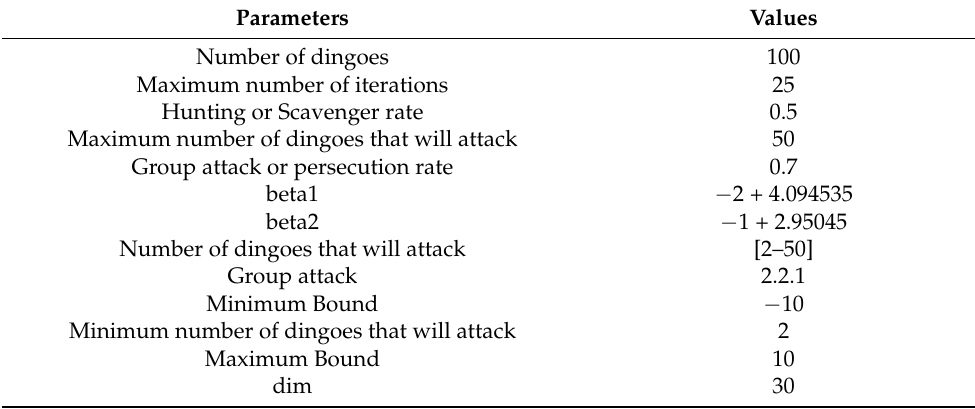
Table 2. The decision variables and the feasibility constraints for designed